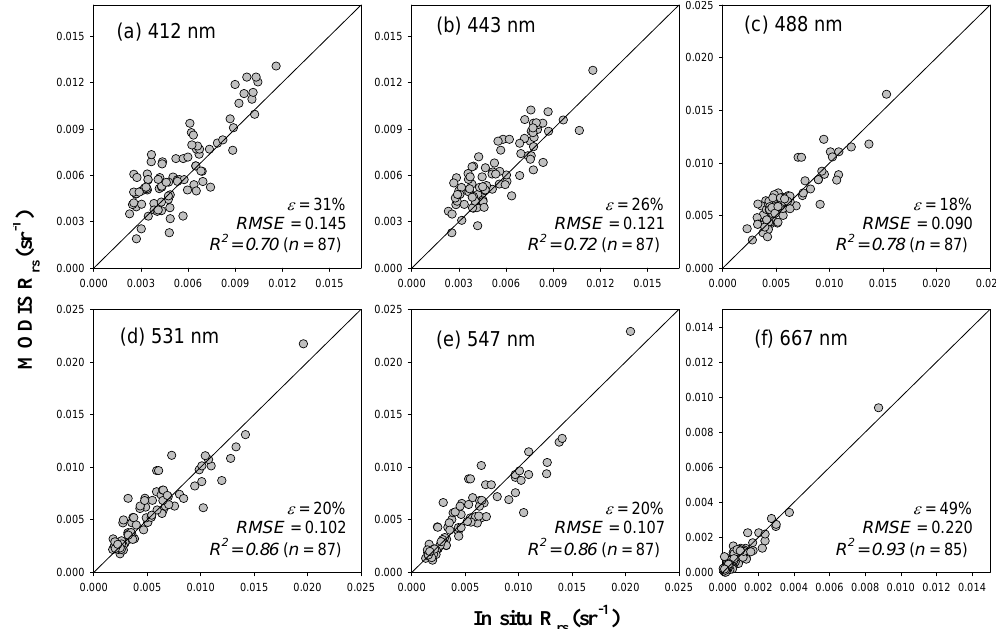
Fig. 10. Comparison between MODIS-derived R rs and field measured R rs .